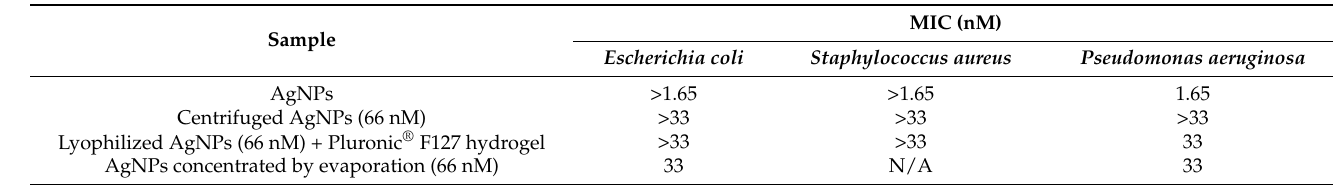
Table 2. Minimum inhibitory concentrations (MIC) for Escherichia coli , Staphylococcus aureus and